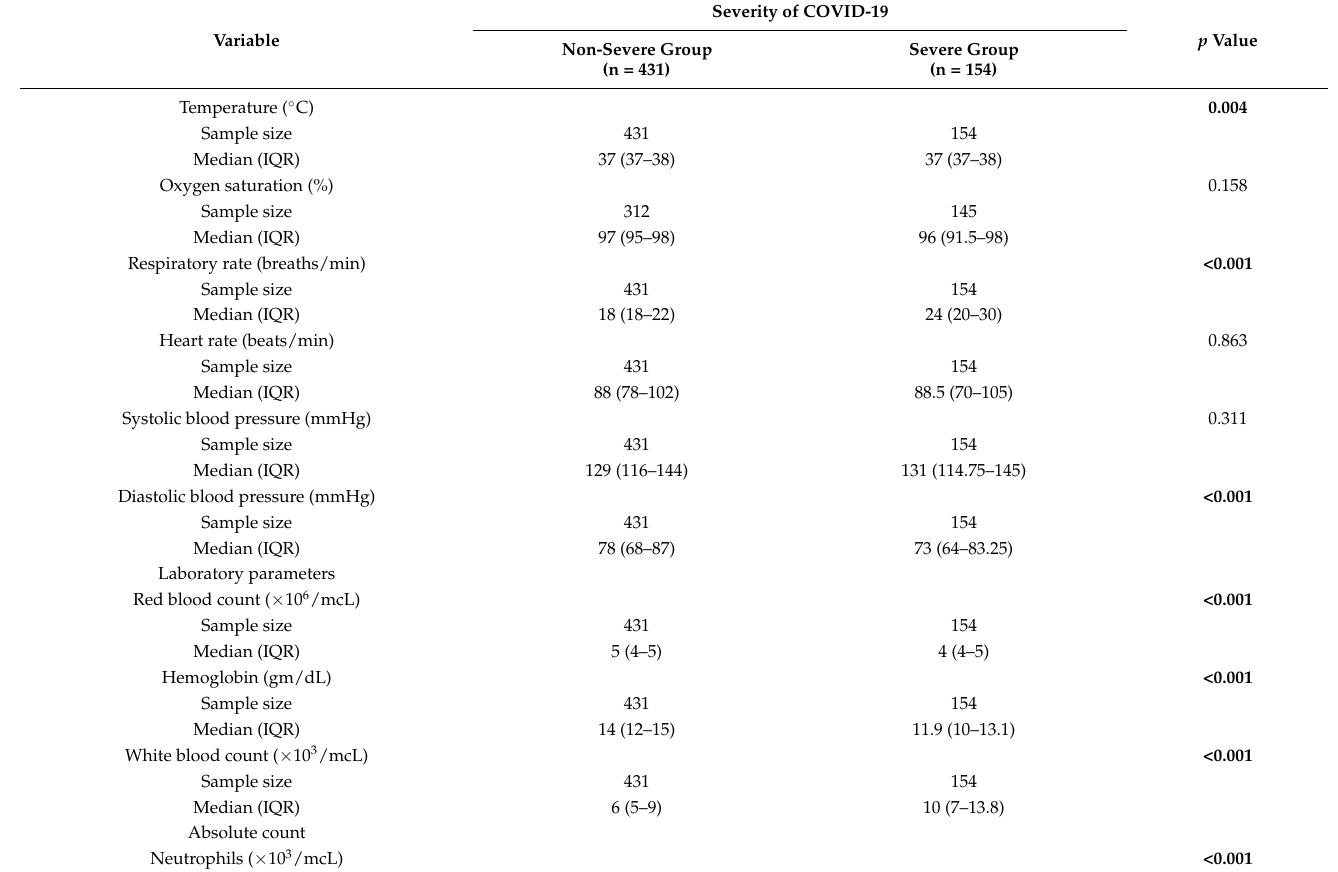
Table 2. Vital signs and laboratory characteristics of study population stratified by severity of